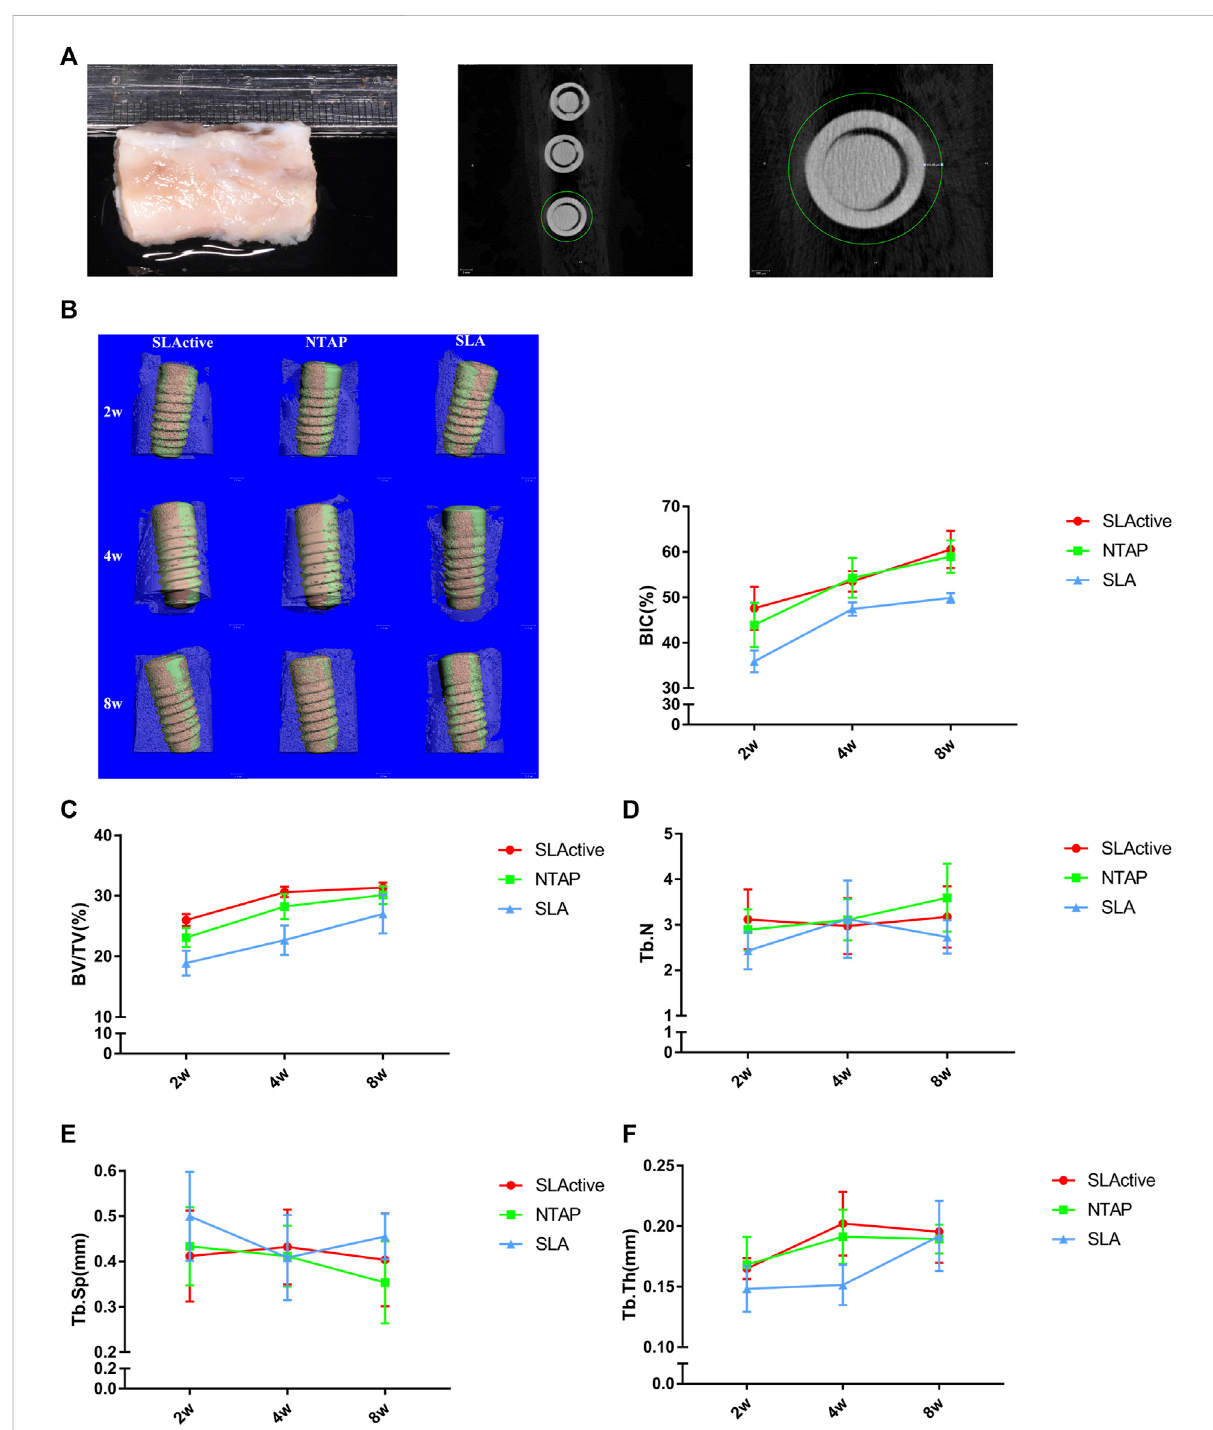
FIGURE 4 Micro-CT analysis of SLActive, NTAP, and SLA implants with the surrounding bone tissue ( n = 4). (A) Mandible specimens with implants and transverse micro-CT view (left), and a region of interest (ROI) was de fi ned as the circumferential region exactly 500 μ m away from the implant surface. (B) BIC% of the implant at 2 w, 4 w, and 8 w (left: 3D reconstruction; orange represents the direct contact between the bone and implants). (C) Bone volume fraction (BV/TV). (D) Trabecular thickness (Tb.N). (E) Trabecular separation (Tb.Sp). (F) Trabecular thickness (Tb.Th). Values represent the means of data obtained from three different experiments with standard deviations. * = p < 0.05 of the Kruskal – Wallis test with the Bonferroni correction using IBM SPSS 26 (the error bars indicate standard